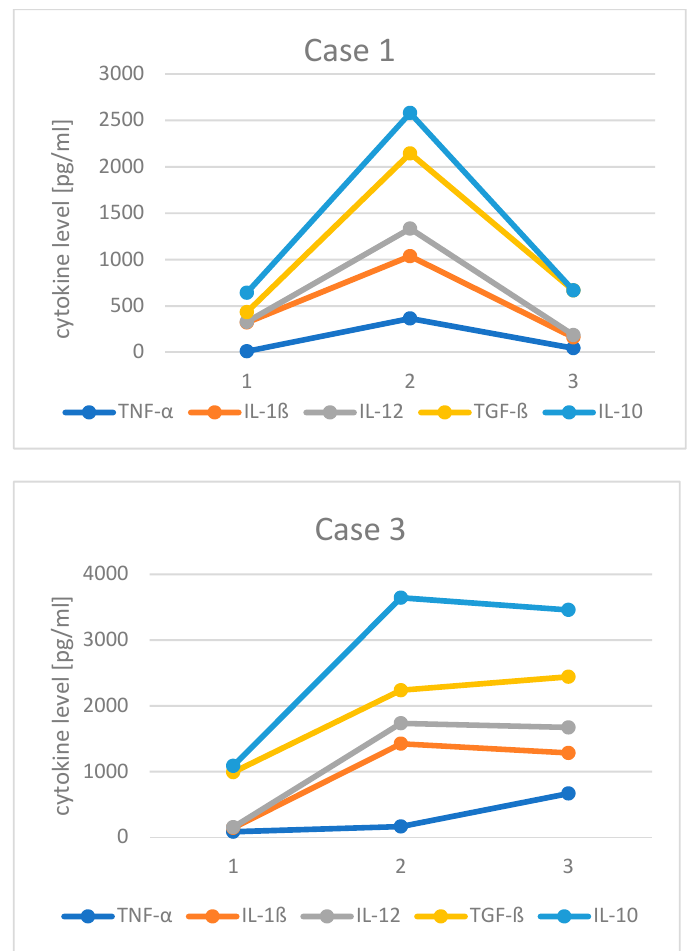
Figure 1. Changes in spontaneous production of TNF- α , IL-1ß, IL-12, TGF-ß, and IL-10 by purified peripheral blood monocytes in Cases 1 and 3 at different time point. Case 1 : time point 1: before COVID-19, time point 2: after suffering from COVID-19, and time point 3: after colchicine treatment. Case 3 : time point 1 before immune activation, time point 2: after immune activation by viral infection (not SARS-CoV-2), time point 3: after suffering from COVID-19.